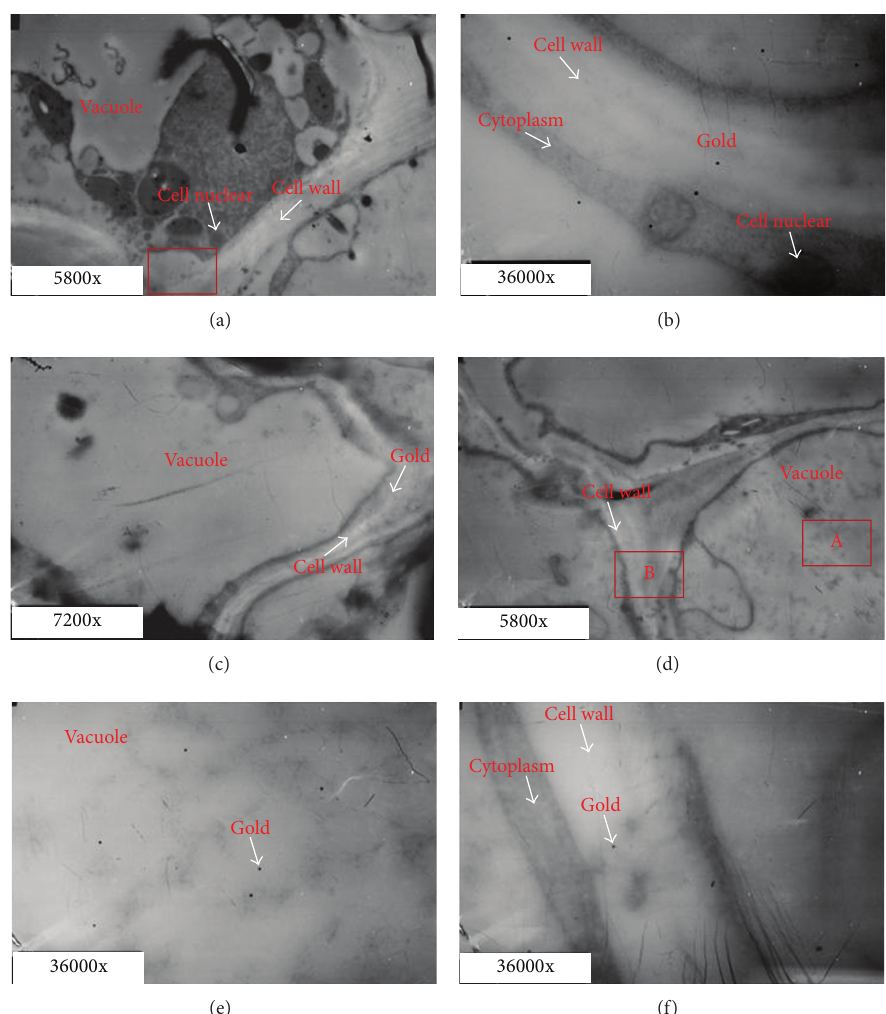
Figure 8: Transmission electron micrographs of tomato pedicel and localization of polygalacturonase (PG) in abscission zone cells by immunogold labeling (Distal end, 24 h). (a), (b), and (c): cortex; (d), (e), and (f): vascular region; (b) is enlarged photo for the rectangles region in (a); (e) and (f) are enlarged photos for the rectangles region of A and B in (d),